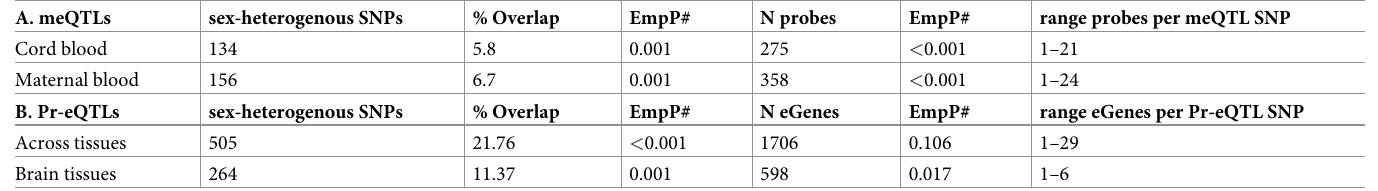
tion ( meQTLs ) at fundamental timepoints for development, we downloaded a comprehensive blood during pregnancy of participants in the Avon Longitudinal Study of Parents and Chil- dren (ALSPAC) [15]. We performed enrichment analysis to assess the overlap between sex-het SNPs and unique meQTLs (P < 1x10 -14) as described in Gaunt et al . [16]. We assessed the num- ber of unique CpG probes for each sex-het meQTL SNP. We estimated an empirical p-value ( empP ) using 1,000 random matched SNP sets as described above (Table 4). Table 4. Overlap between sex-heterogenous SNPs and (A) SNPs influencing DNA methylation (meQTLs), and (B) elastic-net predicted SNPs influencing gene expression across 49 tissues, 13 brain tissues (Pr-eQTLs). A.